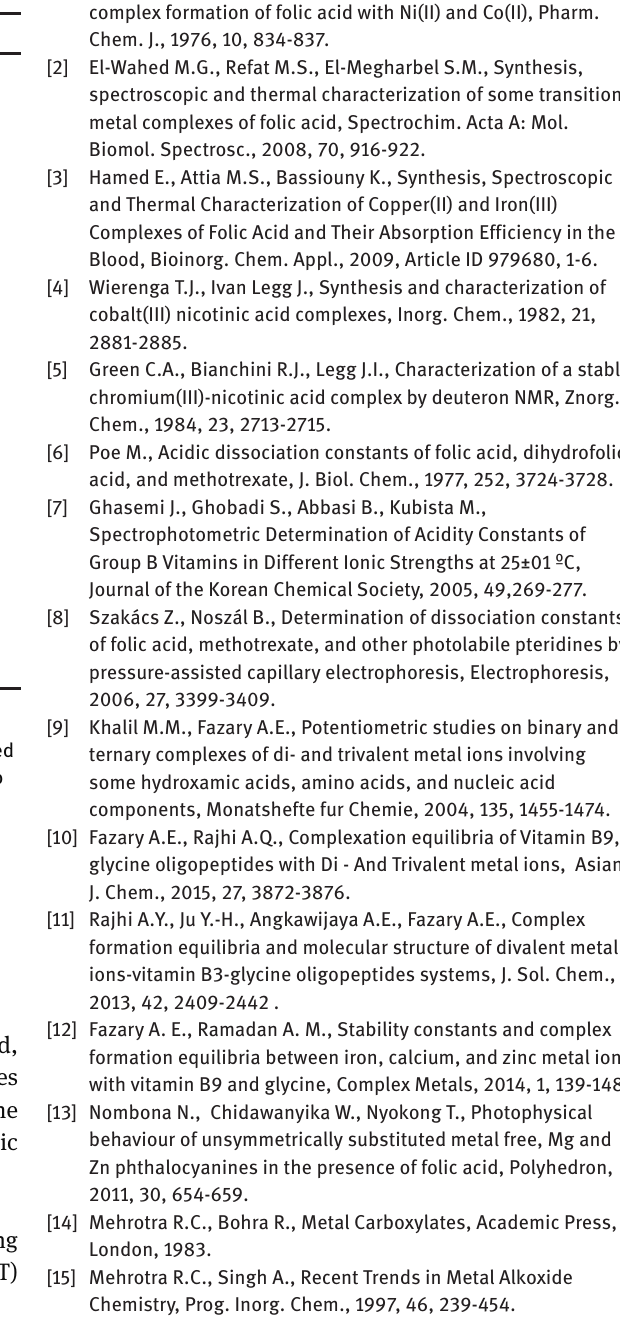
Table 6: DPPH radical scavenging assay of mixed glycine (G) – vitamin (NA/FA) – metal drug